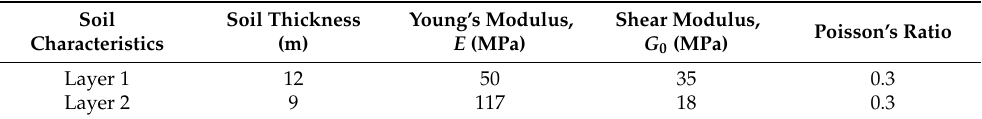
Table 2. Soil characteristics.